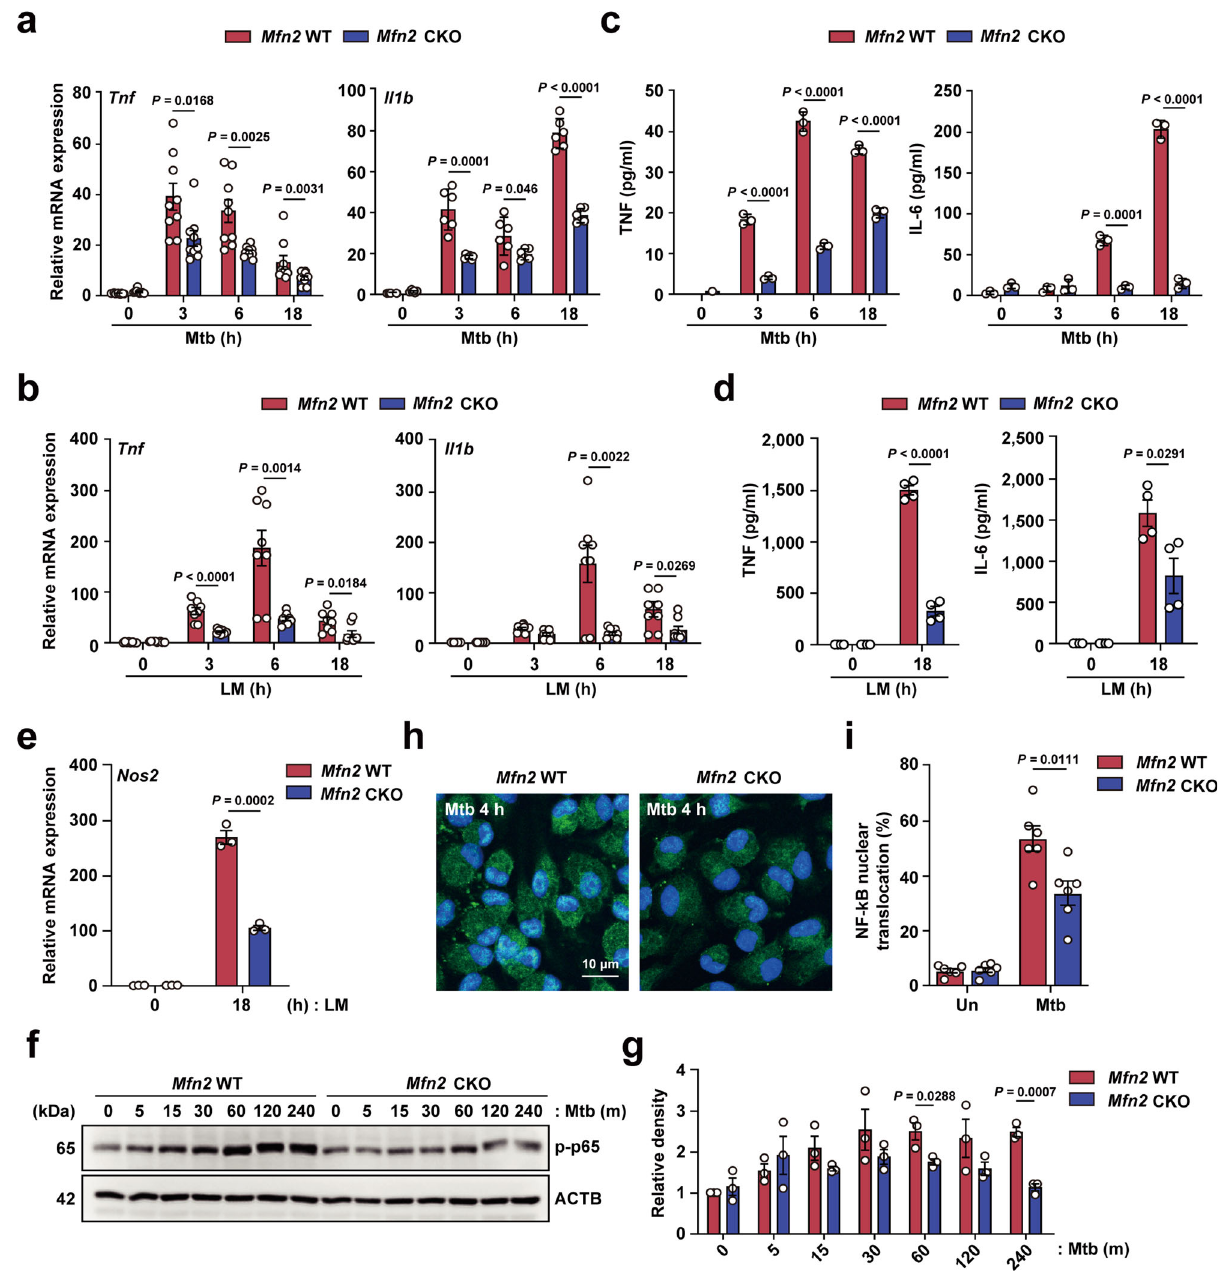
Fig. 2 MFN2 is required for in fl ammatory reaction against bacterial infection. a , b qPCR analysis of Tnf , Il1b mRNA expression in Mfn2 WT and Mfn2 CKO BMDMs after Mtb (MOI 5) ( a ) or LM (MOI 5) ( b ) infection for indicated time ( n = 6). c , d ELISA analysis of TNF and IL-6 in supernatant from Mtb (MOI 5) ( c ) or LM (MOI 5) ( d ) infected Mfn2 WT or Mfn2 CKO BMDMs. e qPCR analysis of Nos2 after LM (MOI 5) infection for indicated time in PMs from